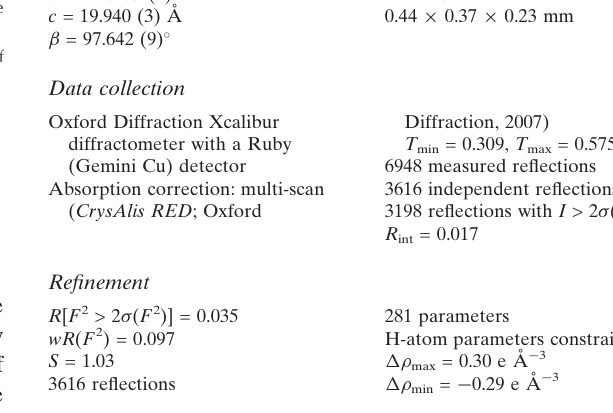
Data collection Oxford Diffraction Xcalibur diffractometer with a Ruby (Gemini Cu) detector Absorption correction: multi-scan